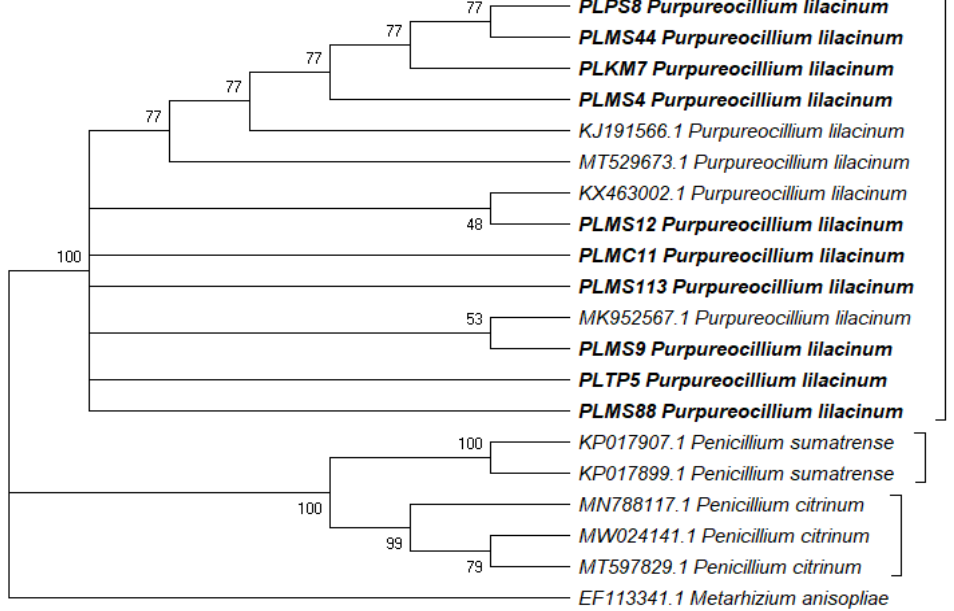
Figure 3. Phylogenetic relationship of 10 fungi isolates following the UPGMA method, using ITS 1-5.8 S-ITS 2 rDNA sequences. The nodes’ bootstrap values were on the basis of 10,000 replicates. Our isolates were represented by bold letters. Metarhizium anisopliae was used as the outgroup in this tree.